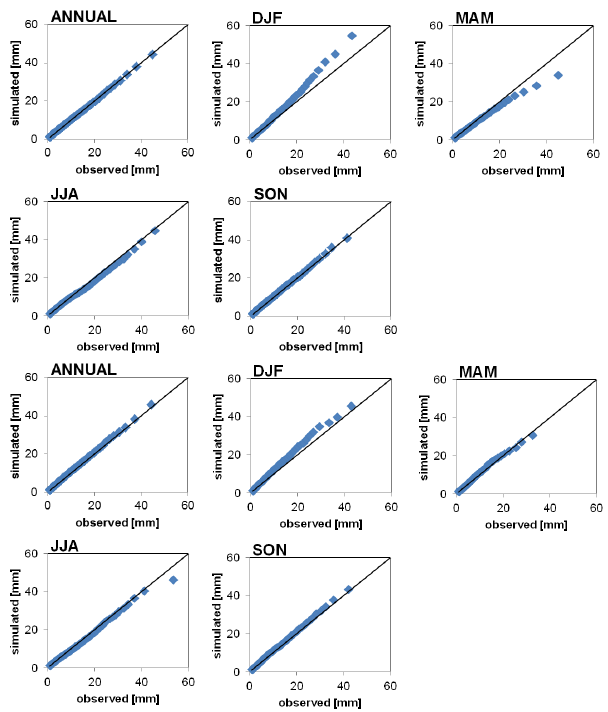
Fig. 3. Percentile-percentile plots showing observed versus down- scaled precipitation on wet days ( > 1mm day − 1 ) using XDS for (a) the calibration (1989–2000) and (b) the validation period (2001– 2005). The XDS model is forced using ECMWF reanalysis